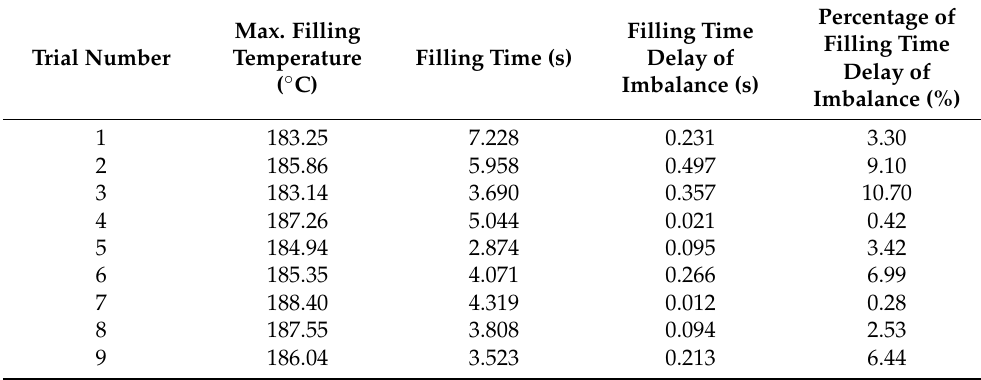
Table 4. Defect determination in the 9 experiments based on Moldex3D simulation